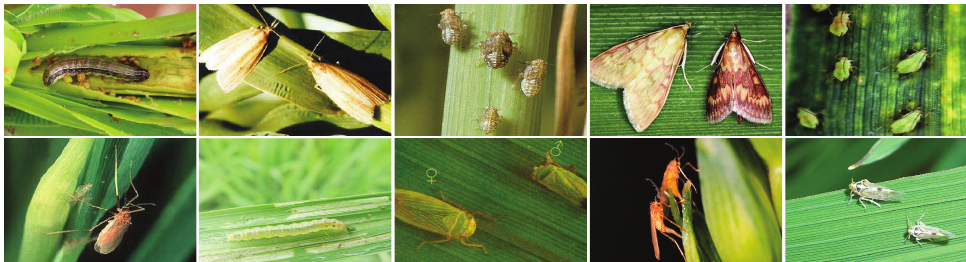
Figure 5. Images including ten categories selected from IP102 dataset. The first gives include the examples of army worm, asiatic rice borer, brown plant hopper, corn borer and English grain aphid; the second row gives the examples of rice gall midge, rice leaf roller, rice leafhopper, wheat blossom midge and white backed plant hopper.